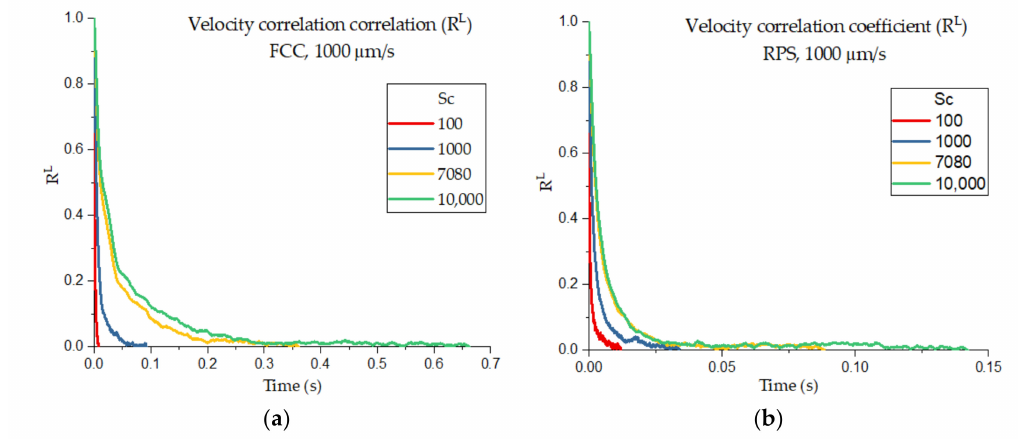
Figure 5. The e ff ect of the Schmidt number on the velocity correlation coe ffi cient, as well as Lagrangian timescales for both cases including the FCC ( a ) and RPS ( b ) configurations at the same average pore velocity of 1000 µ m /